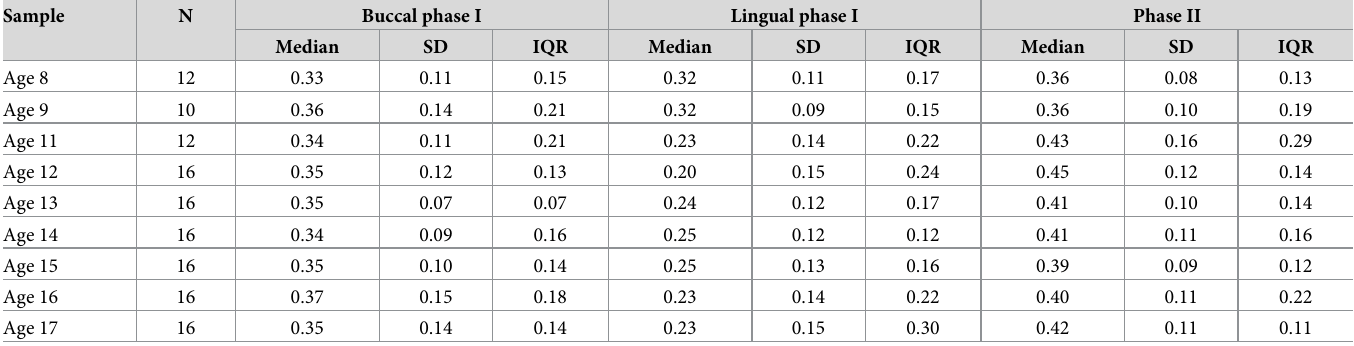
Table 1. Descriptive statistics of relative wear areas of posterior teeth, including age, sample number (N), median, standard deviation (SD) and interquartile range (IQR).